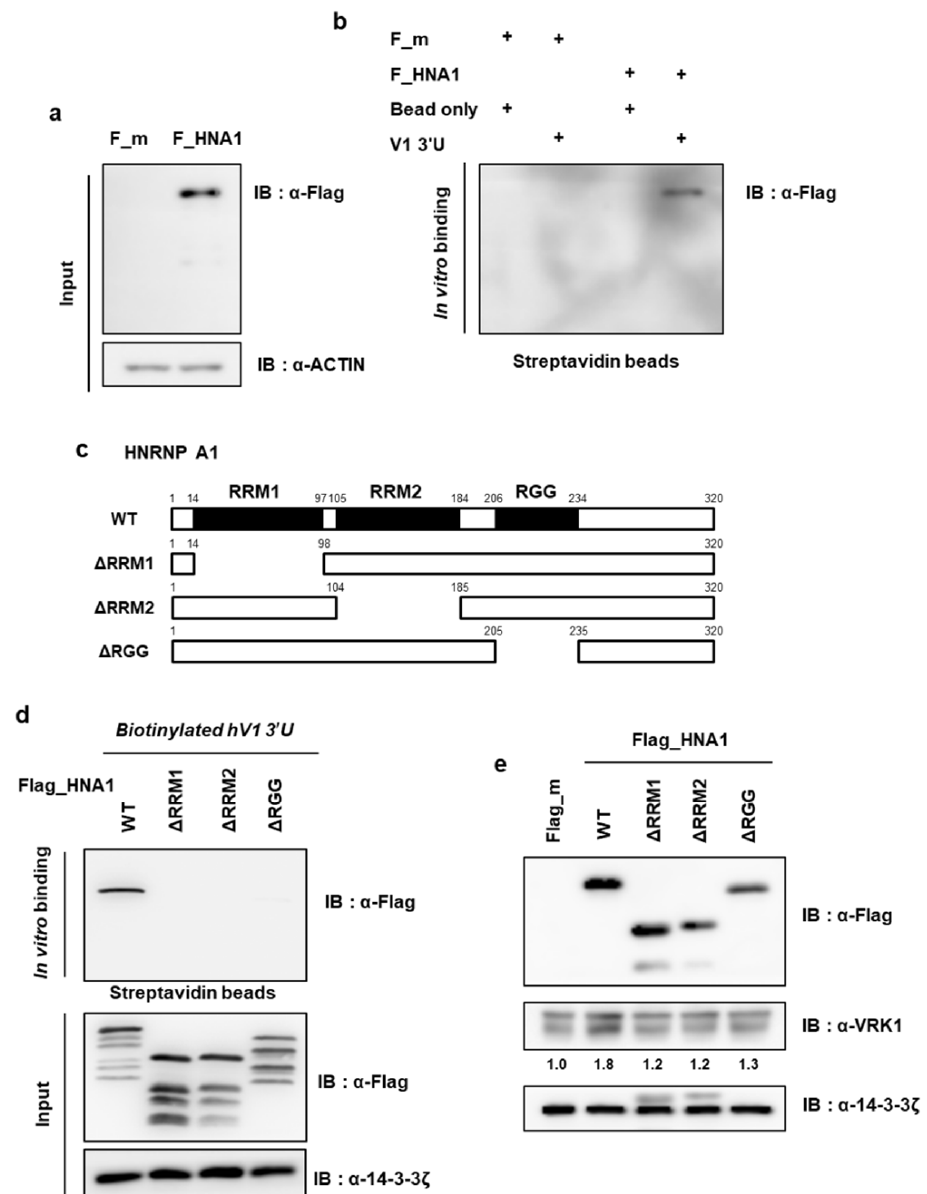
Figure 4. Mapping the interaction domains of HNRNP A1. ( a , b ) The in vitro-transcribed VRK1 3′UTR construct was labeled with biotin-UTP and was incubated with cell lysates of Flag_HNRNP A1 (F_HNA1)-overexpressing HEK293A. Biotin-UTP labelled VRK1 3′UTR was pulled down with streptavidin bead. Streptavidin affinity-purified samples were separated by SDS-PAGE and were subjected to immunoblot analysis with the indicated antibodies. ( c ) Schematic representation of WT HNRNP A1 and its truncation mutants is shown. ( d ) The domain of HNRNP A1 that interacts with the VRK1 3′UTR was mapped by creating truncations of HNRNP A1 tagged with Flag and by testing their interaction using biotin pull-down and immunoblot assay with anti-Flag antibody. ( e ) After the transfection of HEK293A cells with WT HNRNP A1 or its truncation mutants, the levels of VRK1 and loading control, 14-3-3ζ, were analyzed by western blot analysis.